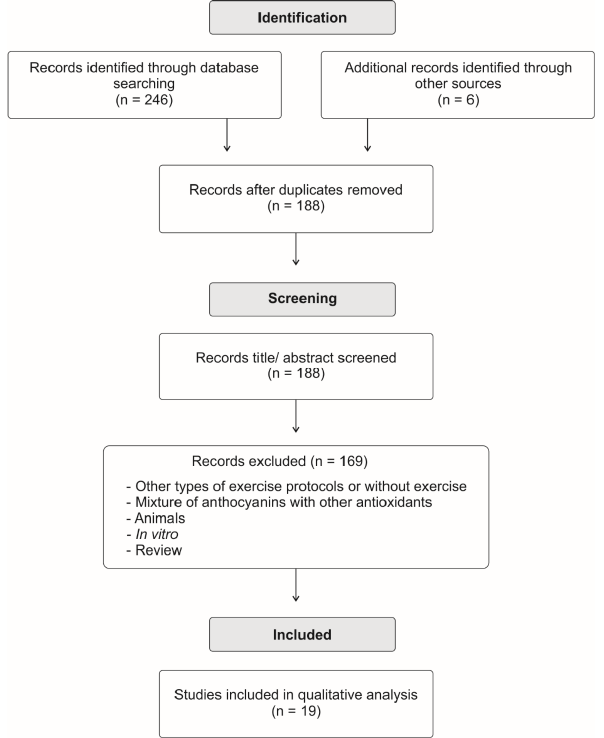
Figure 1. Flow diagram of the literature search process. 3. Fruit-Derived Anthocyanins on Cycling-Induced Responses and Cycling Performance